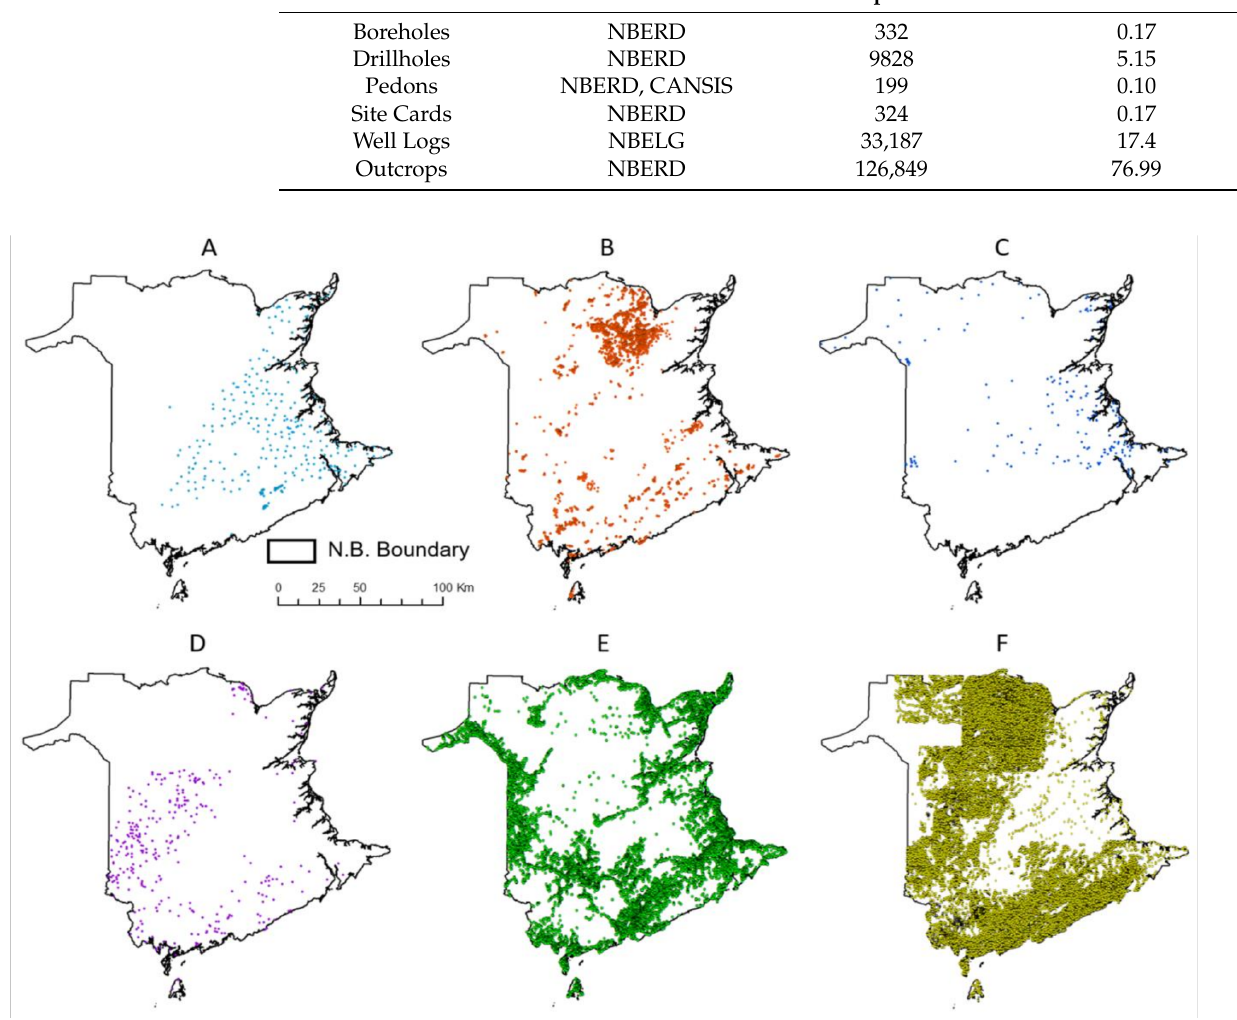
Figure 2. Overview of sample locations for each DTB source: boreholes ( A ); drillholes ( B ); pedons ( C ); site cards ( D ); well logs ( E ); and bedrock outcrops ( F ). Total sample size = 170,719 (see also Table